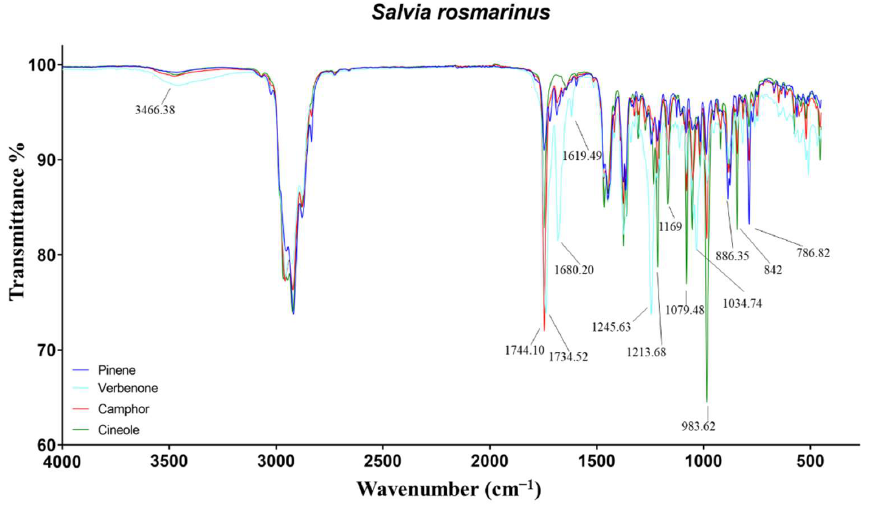
Figure 2. ATR-FTIR spectra of pinene, verbenone, camphor, and cineole chemotypes of Salvia ros-